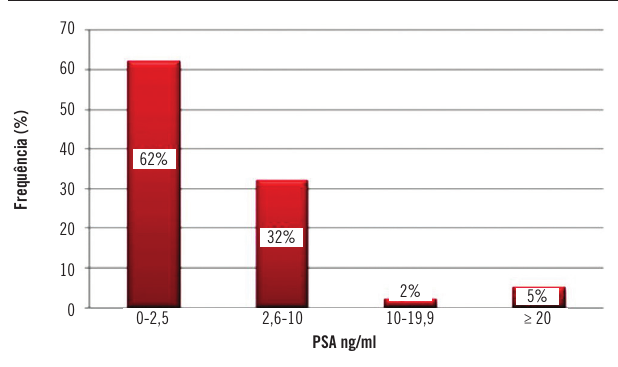
FIGuRA 2 – Distribuição dos pacientes de acordo com a estratificação dos níveis séricos de PSA categorizados em basal, levemente moderado e consideravelmente alto PSA: antígeno prostático específico; DP: desvio padrão.